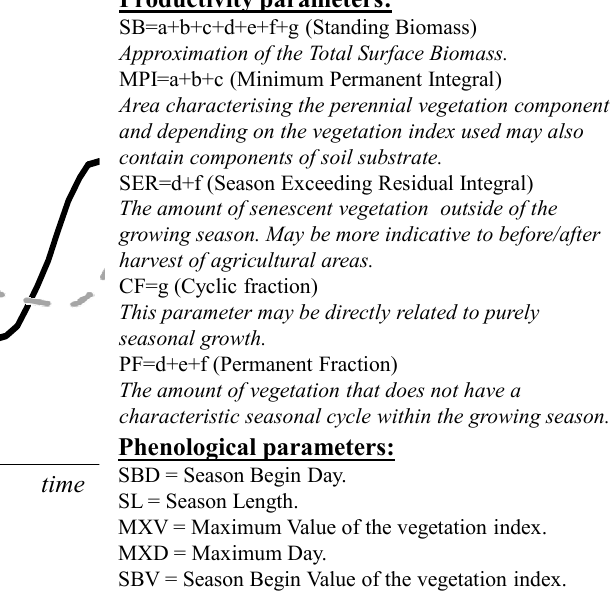
Figure 1. Schematic representation of the phenological and productivity variables calculated by Phenolo. Phenolo calculates all the areas under the time-series curve and all time and value of the depicted points on the yearly time-series curve. In the present study only the most important parameters were employed, which are listed on the right hand